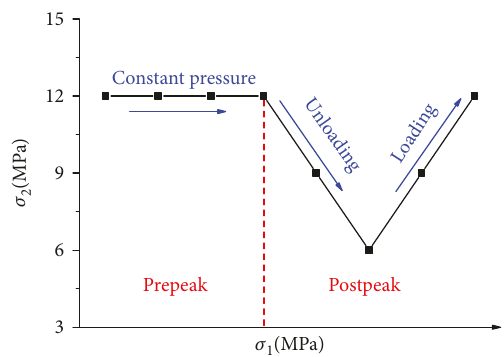
Figure 1: Stress path of samples during the process of postpeak loading and unloading of con fi ning